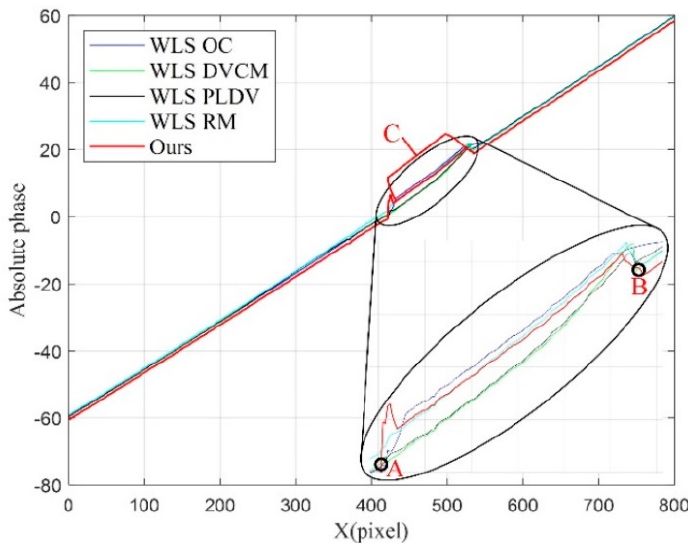
Figure 7. The absolute phase distribution result of 1-D wrapped phase (255th in Figure 6a-2) estimated by five algorithms.